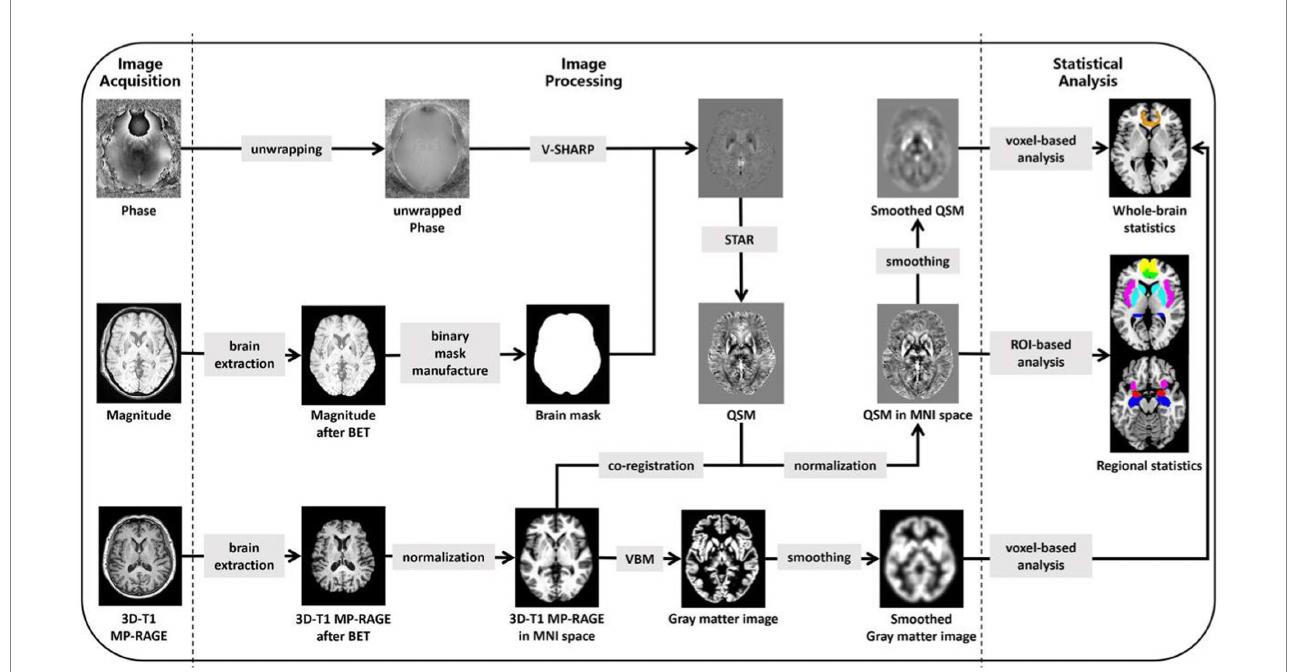
FIGURE 1 Summary steps of the processing for images and statistical analysis. 3D, three-dimensional; MP-RAGE, magnetization prepared rapid acquisition gradient echo; BET, brain extraction tool; V-SHARP, variable-kernel sophisticated harmonic artefact reduction for phase data; STAR, streaking artifact reduction; QSM, Quantitative Susceptibility Mapping; MNI, Montreal Neurological Institute; VBM, voxel-based morphometry; ROI, based on the region of